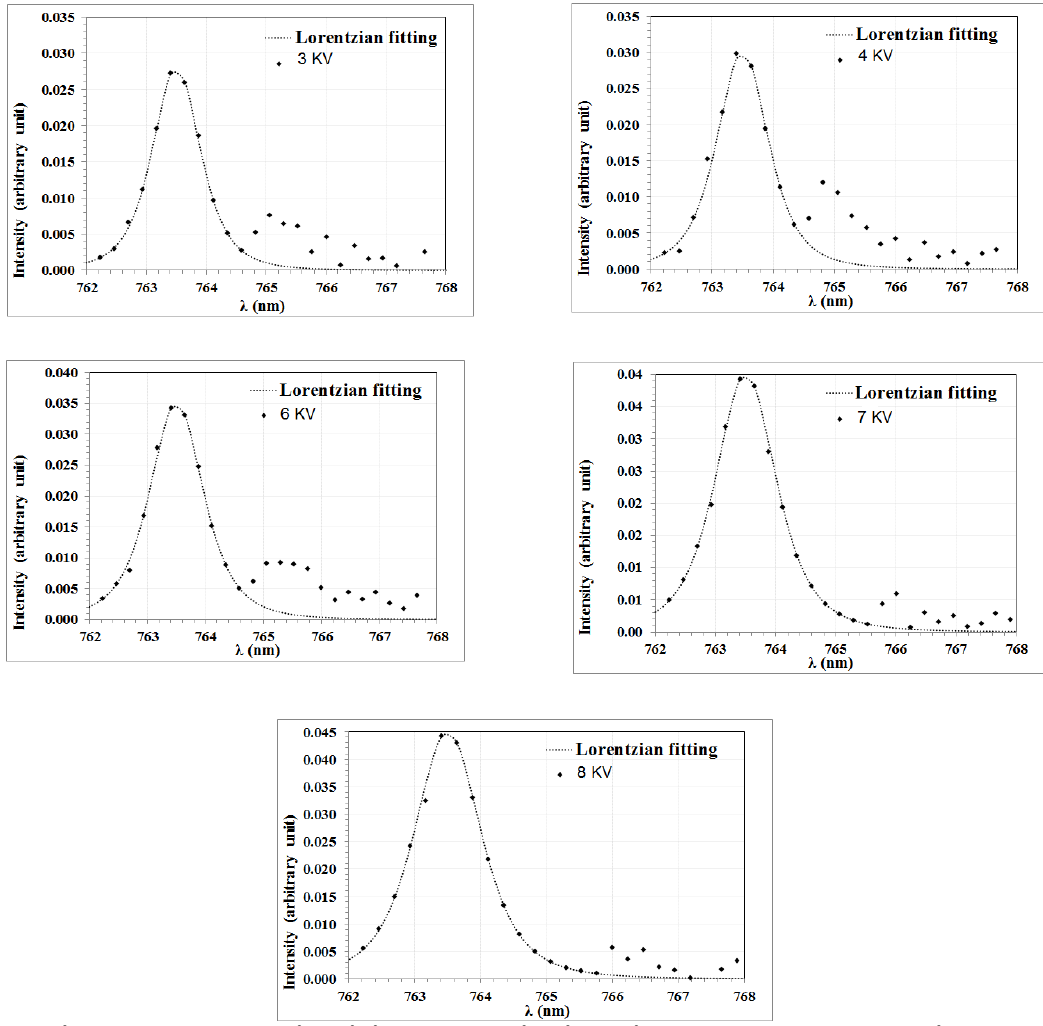
Figure 3: The Lorentzian fitting representing intensity versus wavelength for different voltages with the glass barrier.